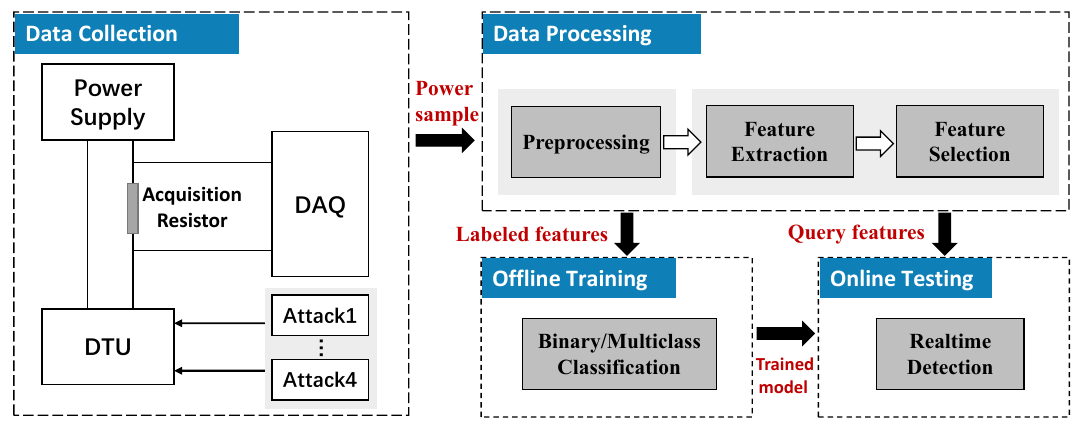
Figure 5. Overview of the real-time monitoring system. It mainly consists of two parts: data collection, and data analysis.